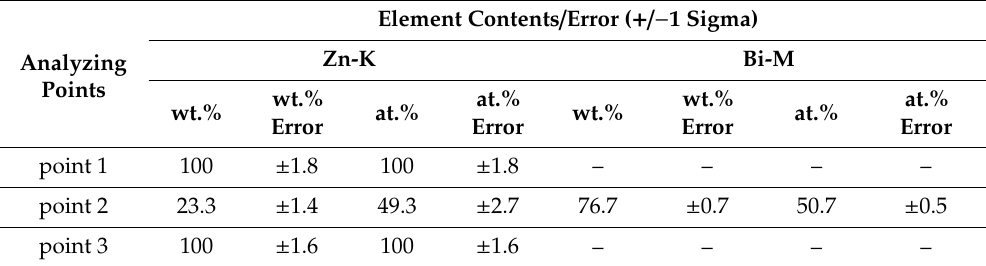
Table 3. The chemical composition in chosen micro-areas on the surface of the Zn–AlNiBi coating (analysis points marked on Figure